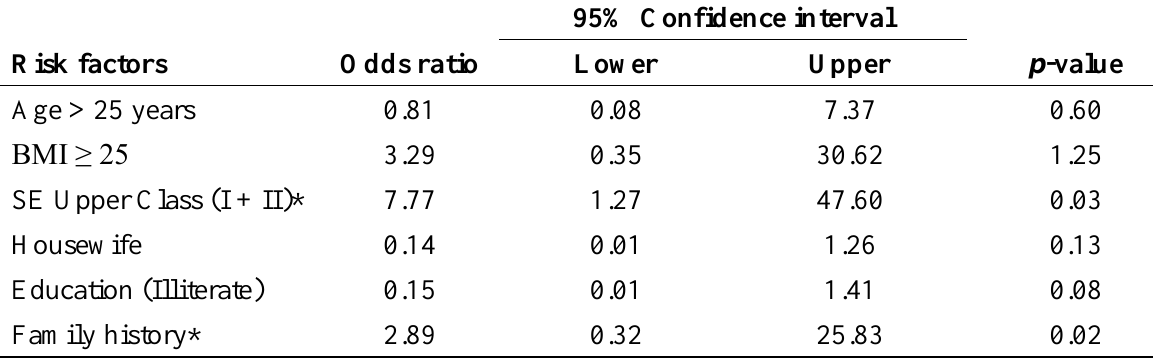
Table 3: Odds ratio for risk factors found to be associated with systolic